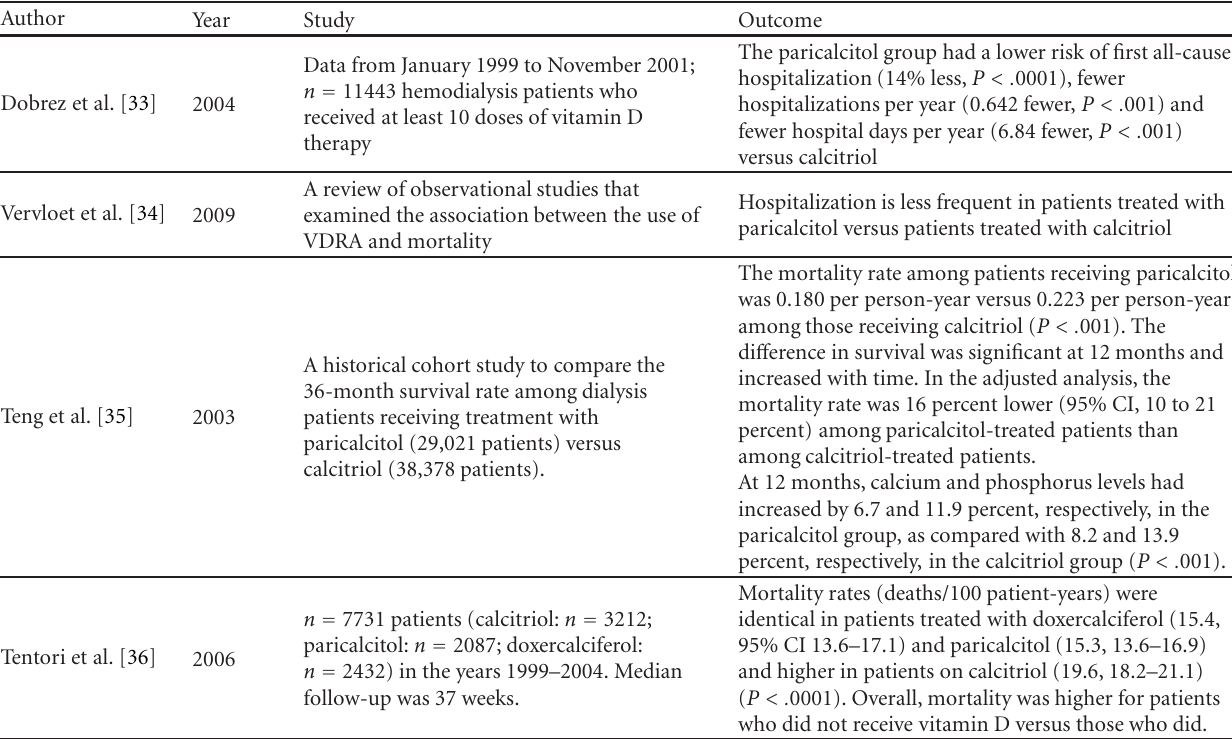
Table 7: Hospitalization and